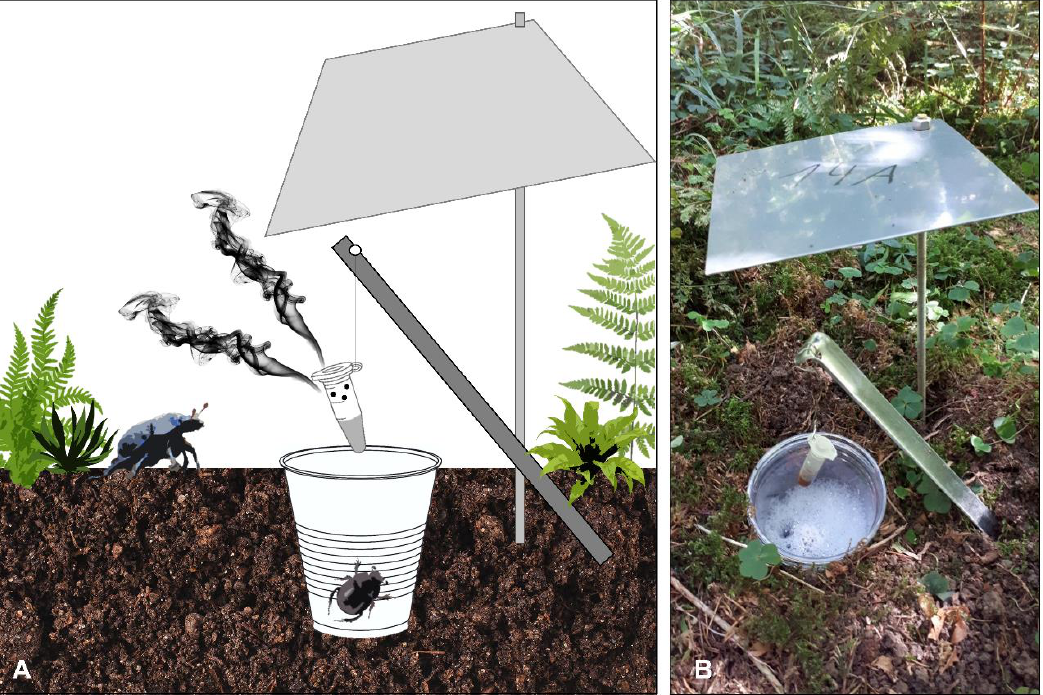
Figure 1. ( A ) Graphic illustration of a pitfall trap with bait (treatment) in a perforated Eppendorf tube used in the field assays and ( B ) the corresponding setup as an original image.